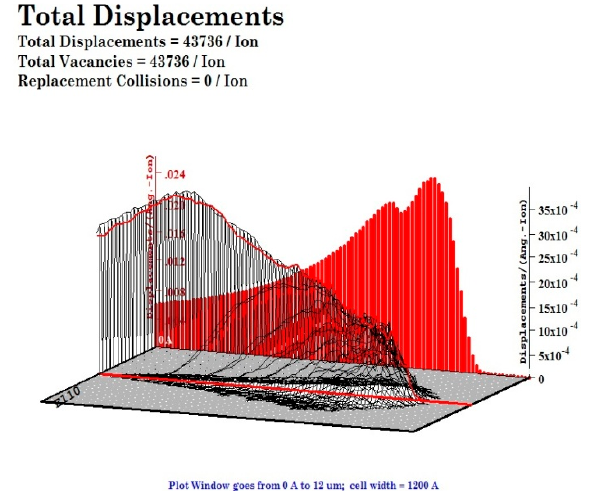
Figure 18. Damage caused by 95 MeV Cs in E110 alloy.